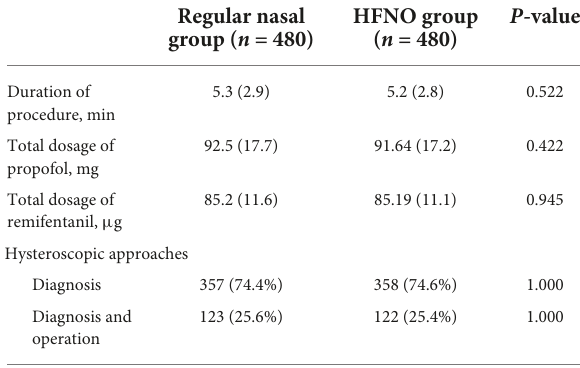
TABLE 1 General characteristics of the patients undergoing elective diagnostic or operative hysteroscopy. TABLE 2 Data of sedated hysteroscopy